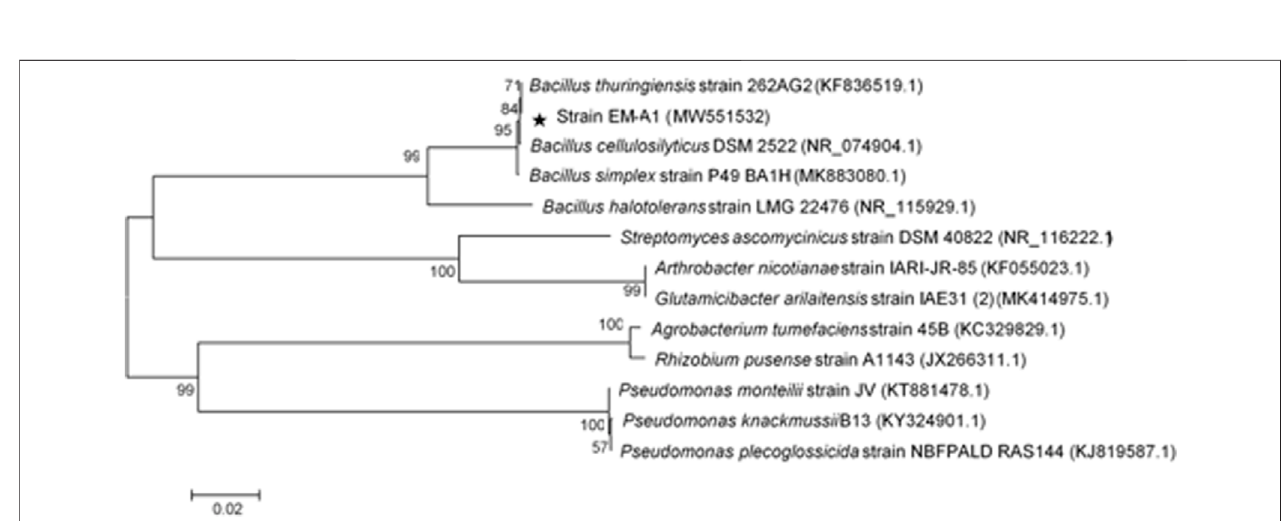
FIGURE 2 | Neighbor-joining phylogenetic tree of the strain EM-A1 and related bacteria based on 16S rRNA sequence comparisons.